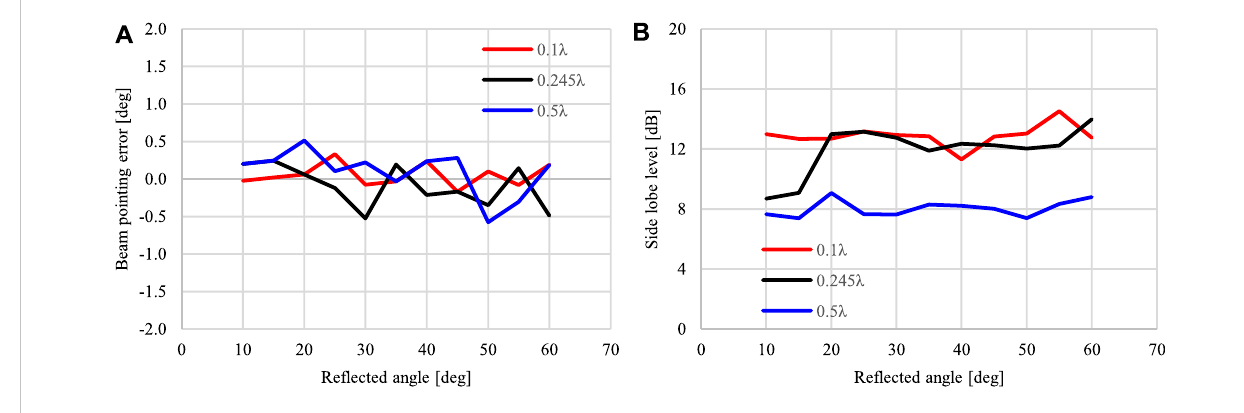
FIGURE 10 RIS array factor performance for different unit cell sizes. (A) Beam pointing error. (B) Side lobe level.